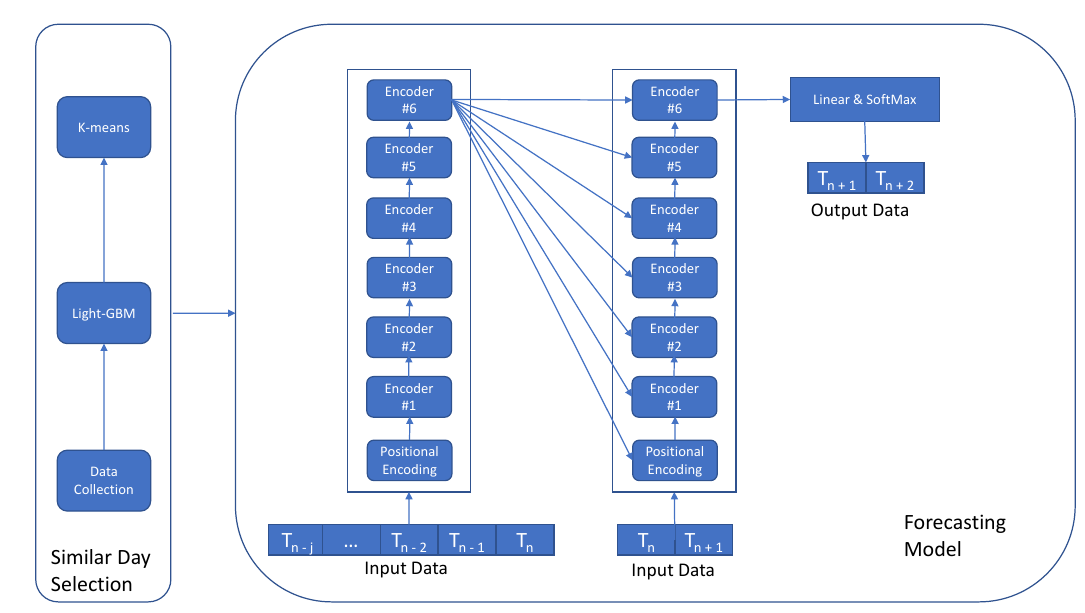
Figure 4. The entire architecture of the forecasting